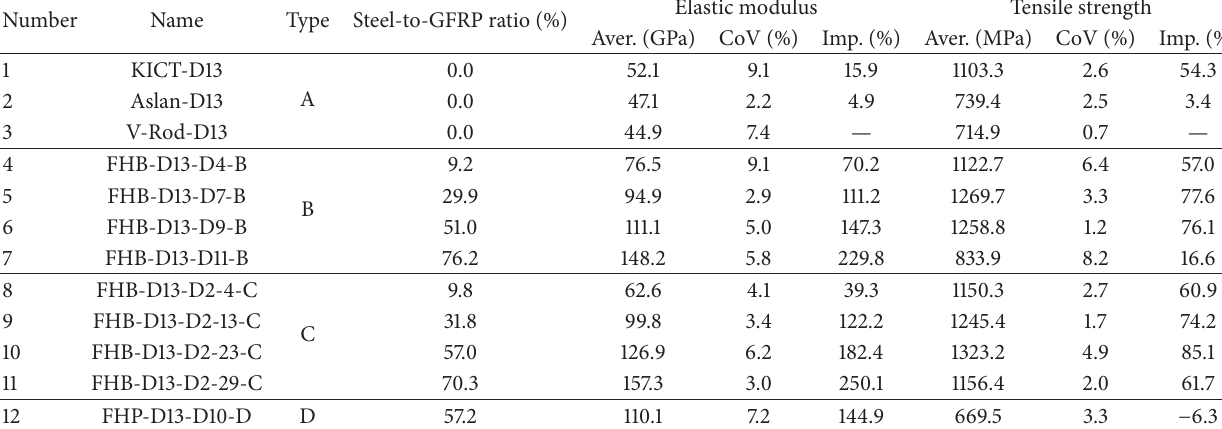
Table 3: Test results for D13 FRP Hybrid Bar.